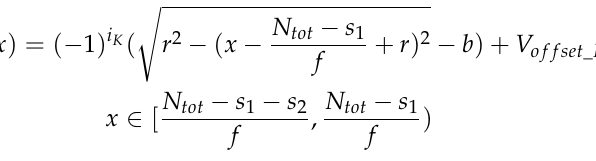
where y b _ arc ( x ) represents the behind arc part of the missing teeth signal. Stage 6: Behind missing tooth sine modeling. For the behind sinusoidal part of the missing teeth CKP signal, the sinusoidal waveform of s 1 times the period is generated according to Equation (15).